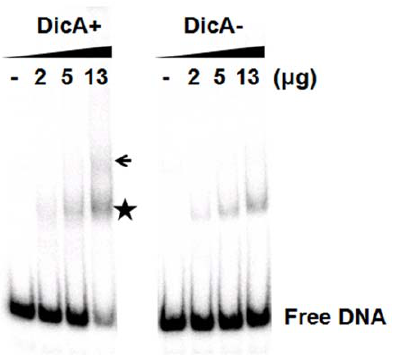
Figure 7. In vitro measurements of DicA binding to Oc. Electrophoretic mobility shift assay was performed with radio-labeled 90-bp DNA containing Oc. Soluble protein extracts from BL21 (DE3) cells harboring pHis-DicA (Fig. 1) of 0, 2, 5, or 13 m g were used in the binding assay (Fig. S2). DicA + indicates DicA induced with IPTG. DicA 2 indicates no DicA induction. The binding reaction was incubated for 20 min at 25 u C, and subjected to electrophoresis on a 5% poly- acrylamide gel.